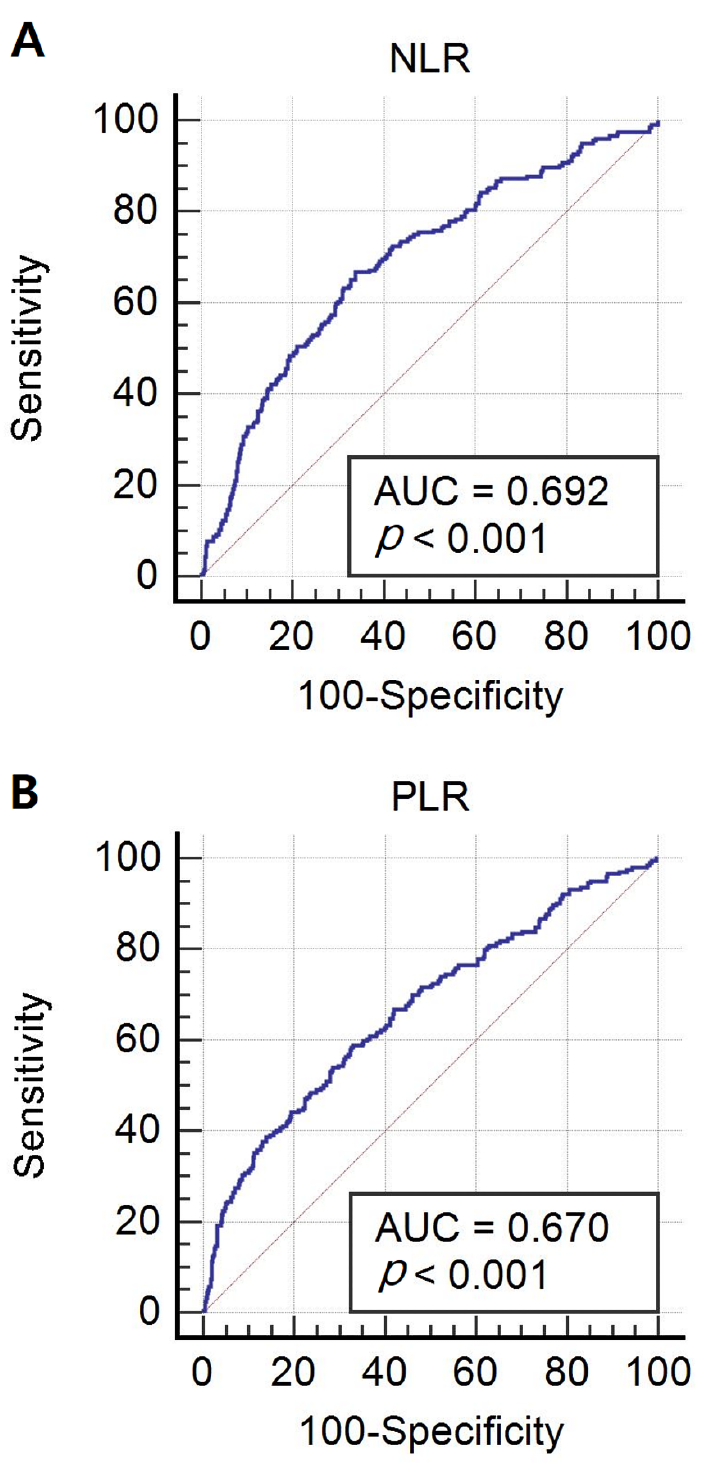
Figure 1. Receiver operating characteristic curve analysis of NLR ( A ) and PLR ( B ) in patients with benign or borderline versus malignant ovarian tumor. Abbreviations: NLR, neutrophil to lymphocyte ratio; PLR, platelet to lymphocyte ratio; AUC, area under curve.